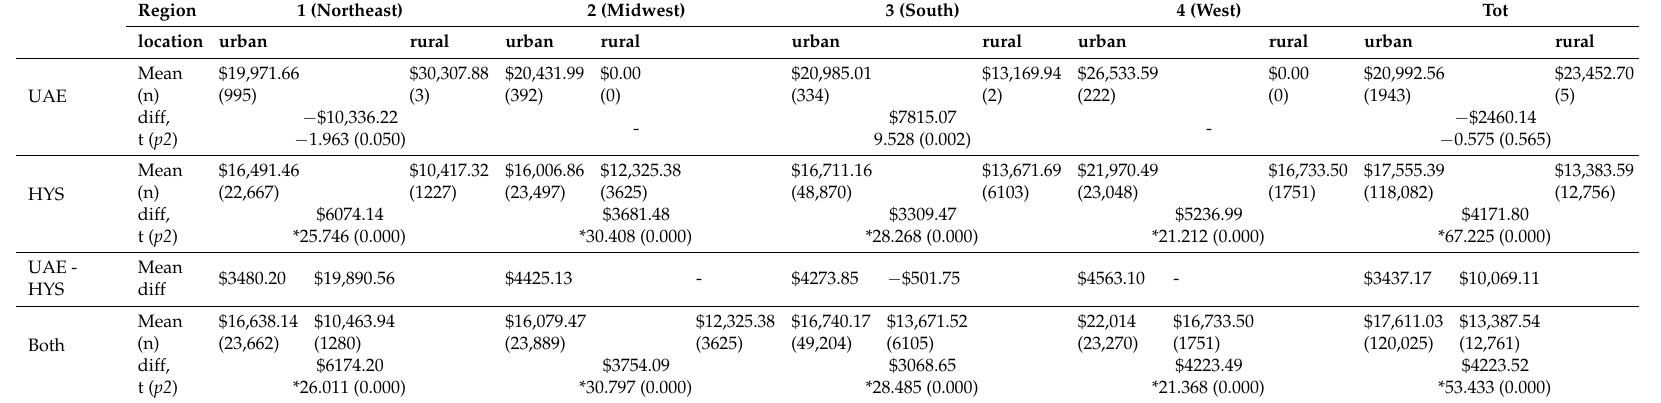
Table 3. Mean Cost of Care for UAE and AHYS in the U.S.A. by Region and Location for the years 2004-2008 – Trimmed Data.